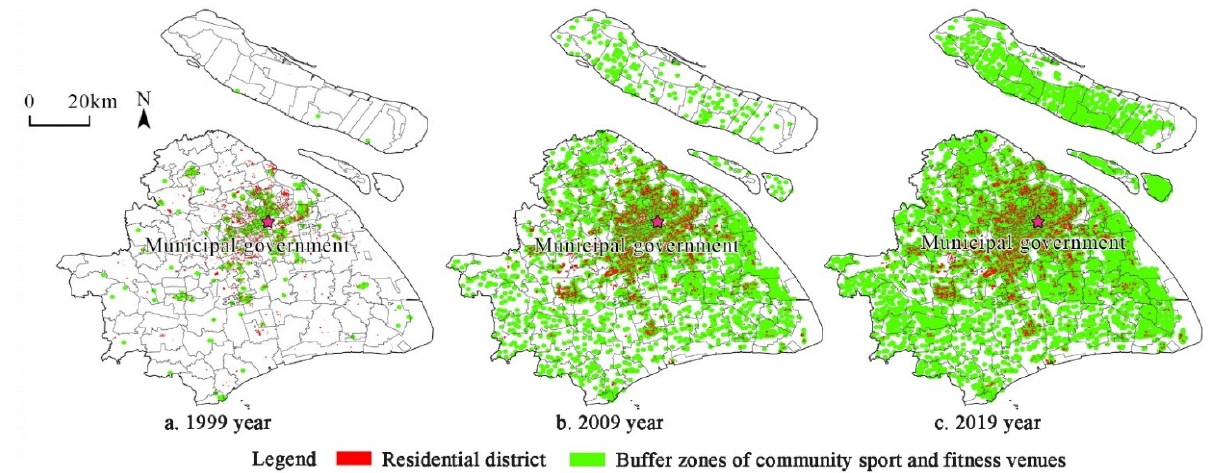
Figure 1. Service range of Shanghai’s community sports and fitness venues in 1999, 2009, and 2019.